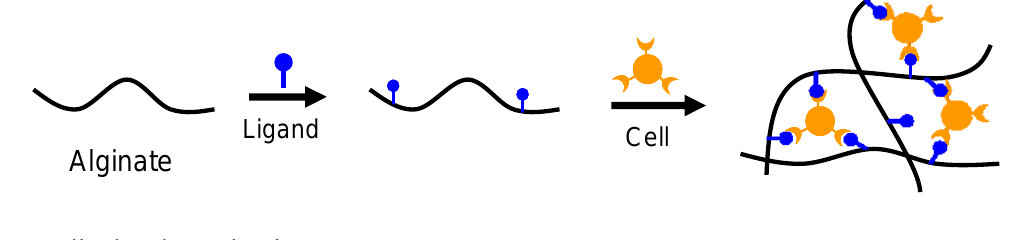
Figure 3. Schematic showing cell-crosslinked network formation of ligand modified